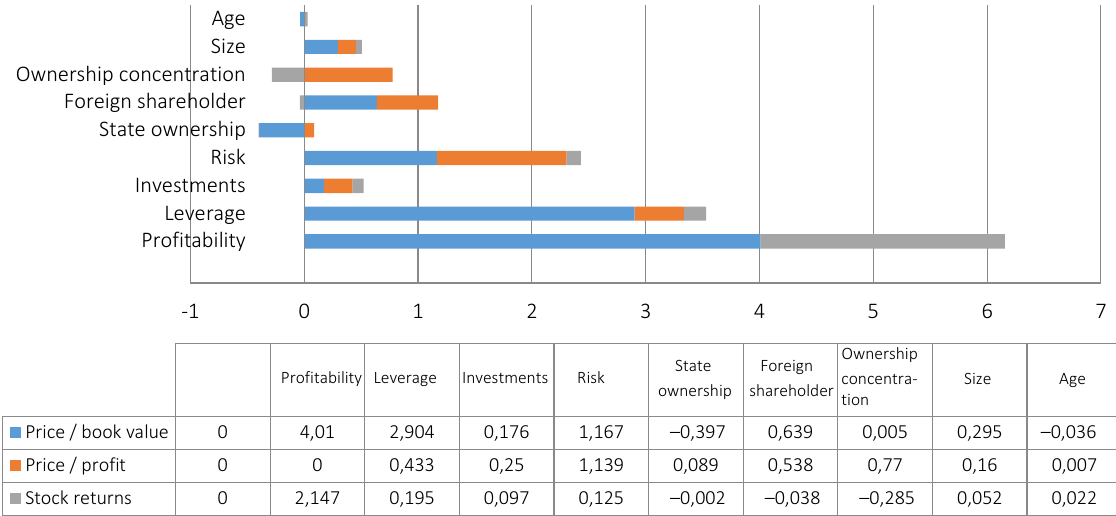
Figure 5. Probit model estimates